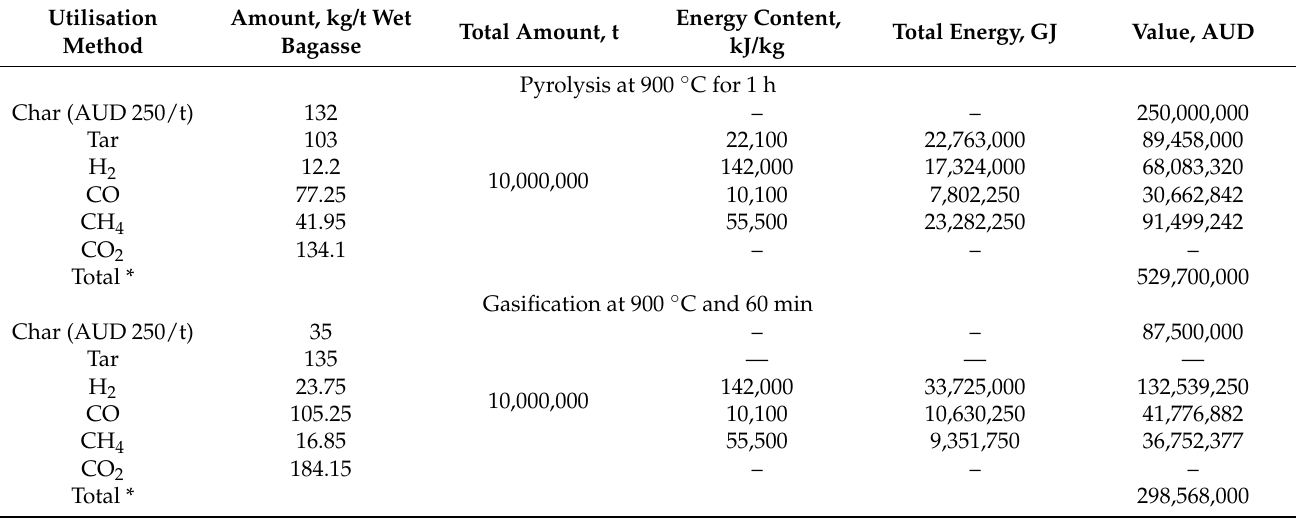
Table 31. The potential energy and revenue from pyrolysis and gasification. Utilisation